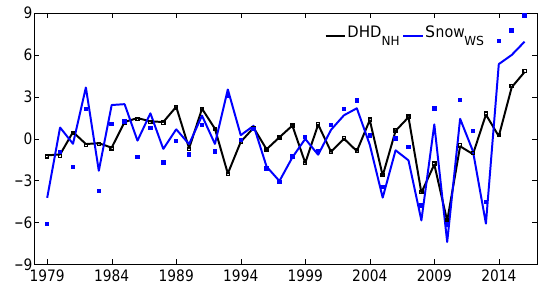
Figure 13. Variation of the DHD NH (black) and Snow WS (blue) in- dices from 1979 to 2016. The solid lines indicate the indices whose linear trends were removed and the symbols without lines are the original